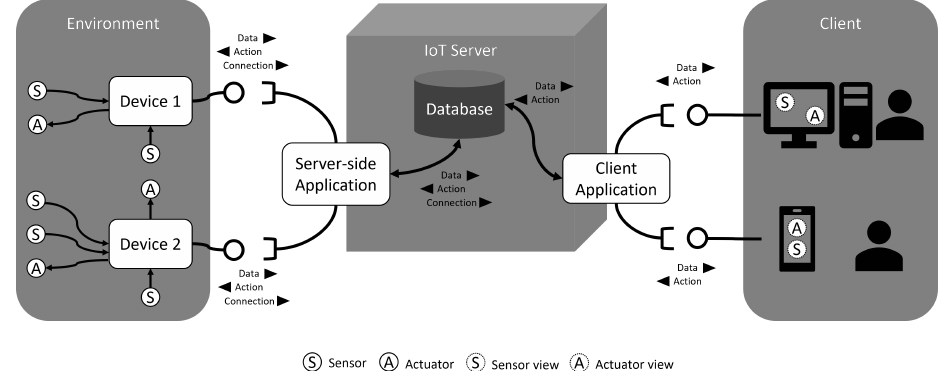
Figure 1. The RMA